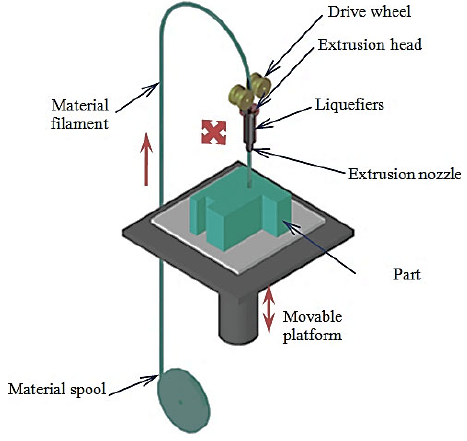
Fig. 9 Schematic illustration of FDM